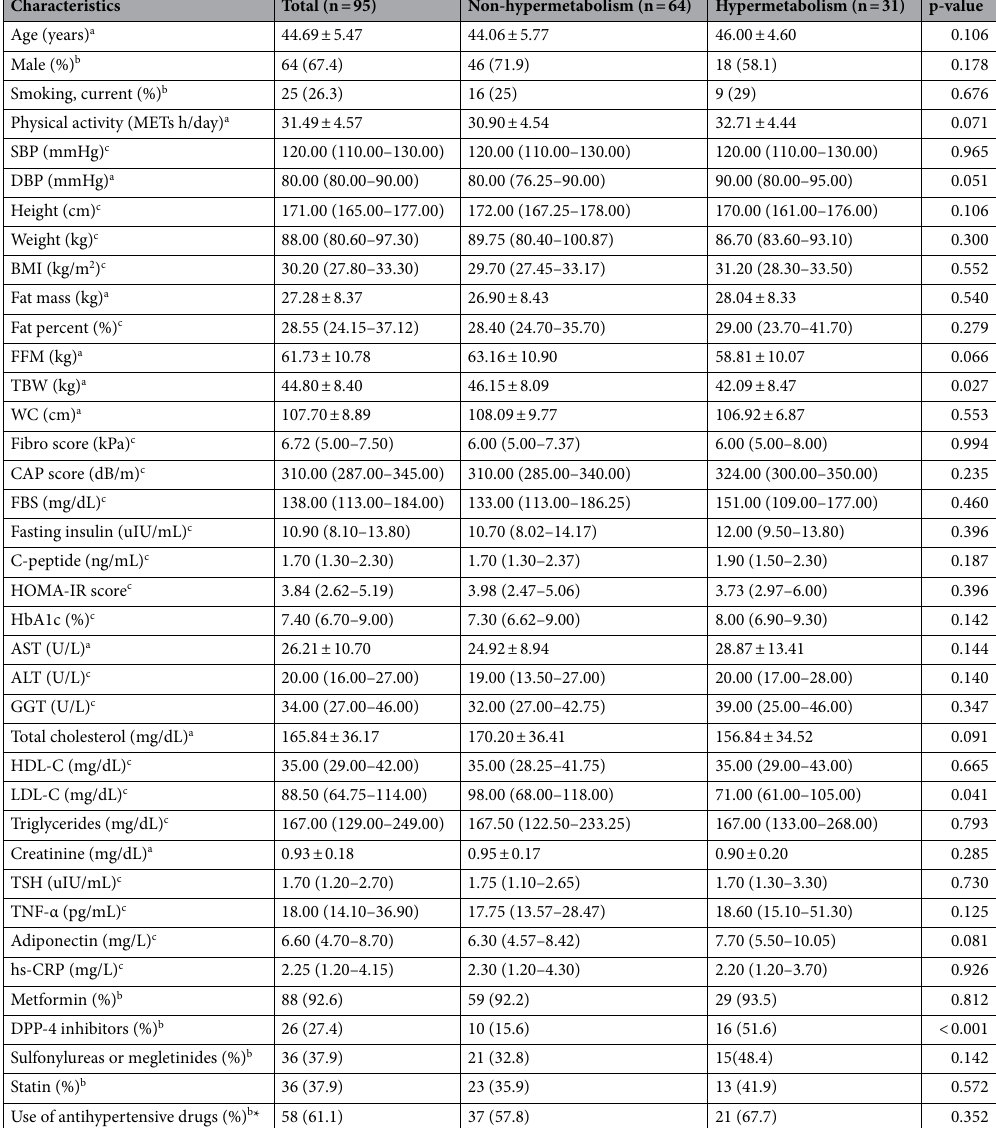
Table 1. Demographic, anthropometric and biochemical characteristics of patients with NAFLD and diabetes, according to metabolism categories. Data are presented as mean ± SD, median (IQR) or number (%).